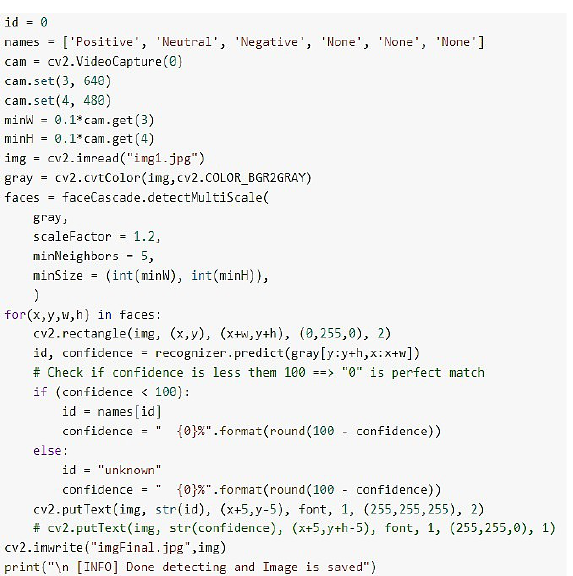
Fig.3. Haar Features[8]